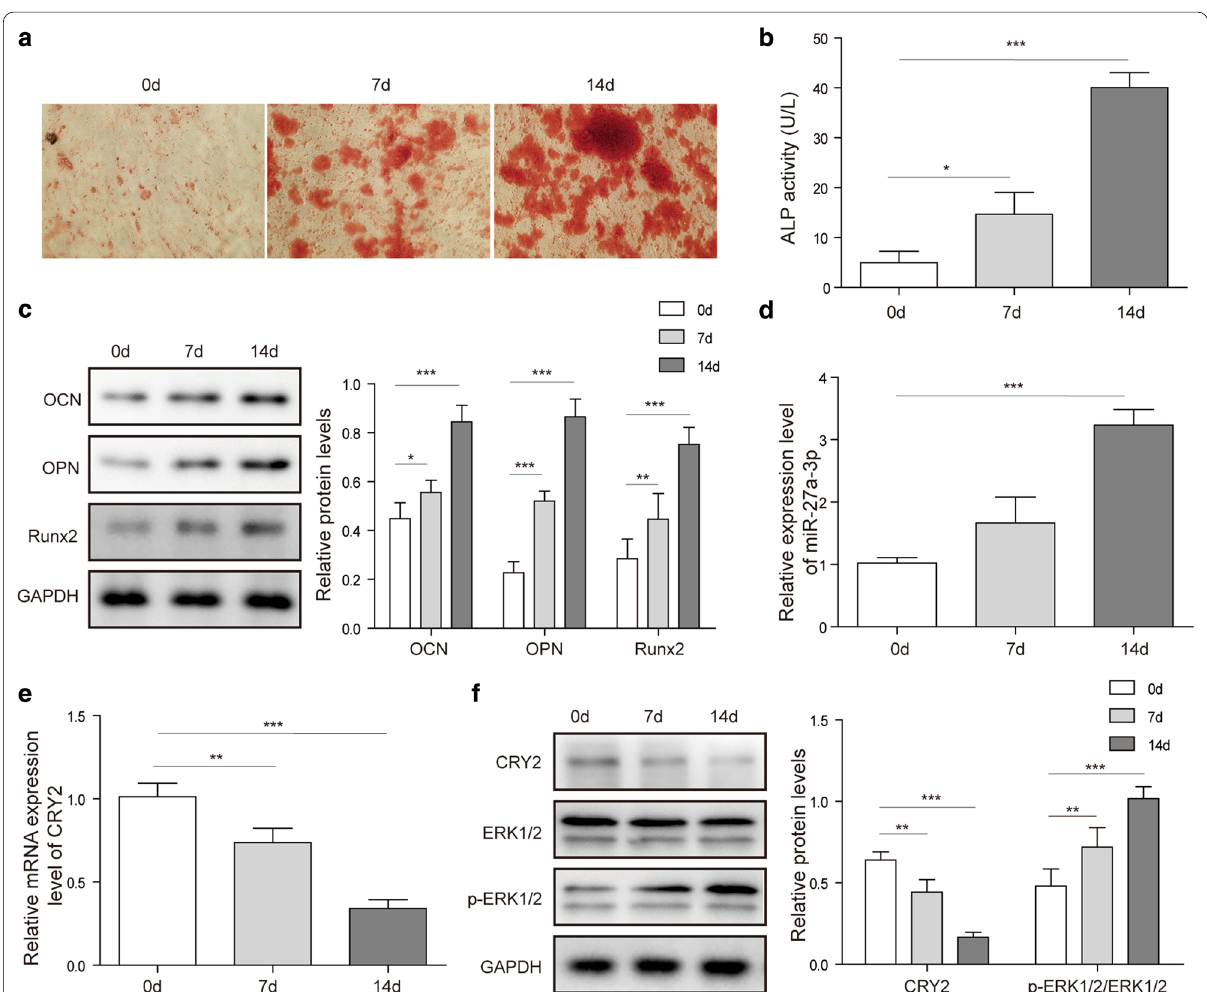
Fig. 1 Expression of miR‑27a‑3p and CRY2 were detected in MC3T3‑E1 cells. MC3T3‑E1 cells were cultured with OIM. a Alizarin Red staining in MC3T3‑E1 cells. b Detection of ALP activity. c The expression of OCN, OPN and RUNX2 were measured by western blotting. d , e RT‑qPCR tested miR‑27a‑3p and CRY2 levels. f Western blotting analyzed the level of ERK1/2. *P < 0.05, **P < 0.01, ***P <